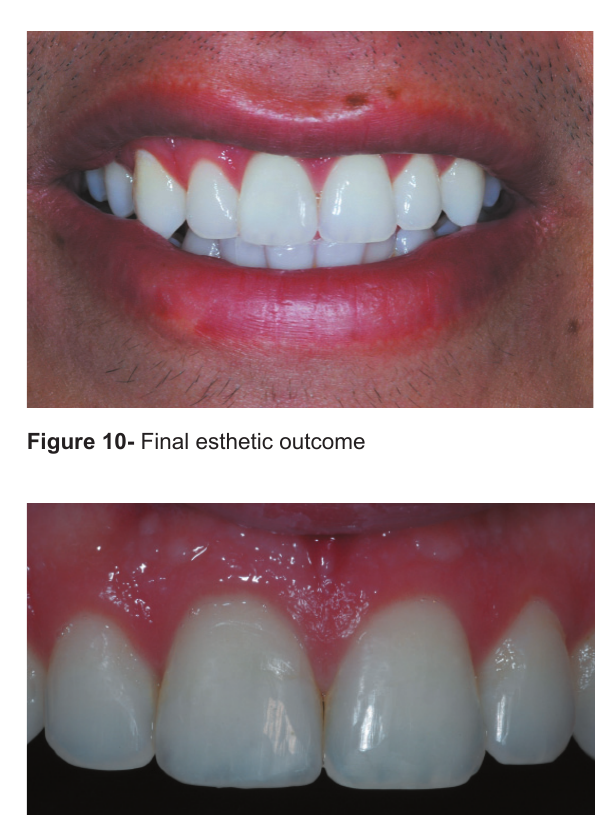
Figure 9- Application of Amaris ® TN over the other shades, reproducing the buccal enamel